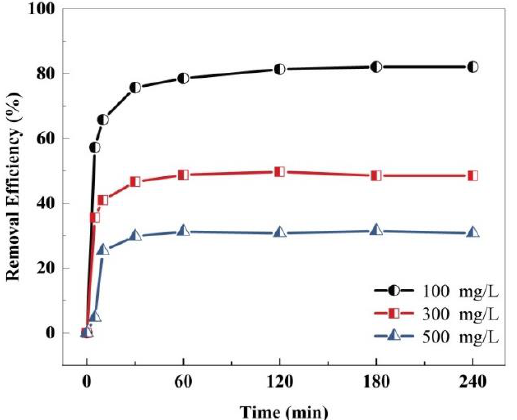
Figure 5. Effect of initial humic acid (HA) concentration on the adsorption of HA onto RGO-SiO 2.